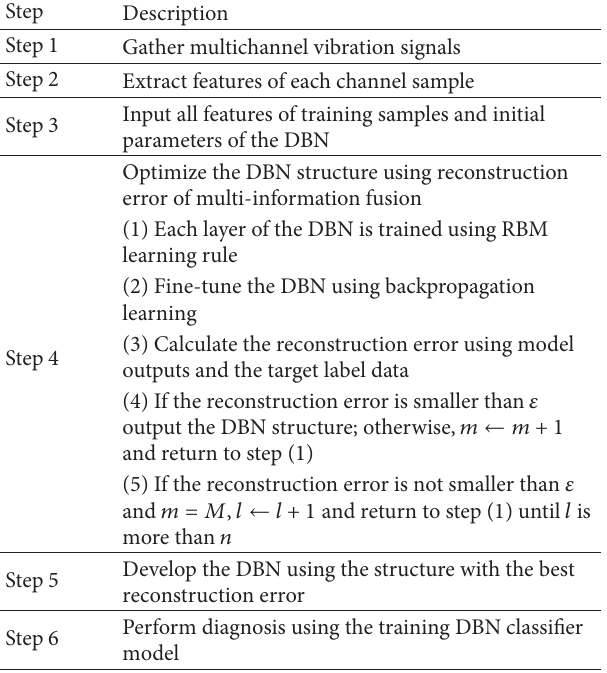
Table 1: Procedure for bearing fault diagnosis using multi-informa- tion with